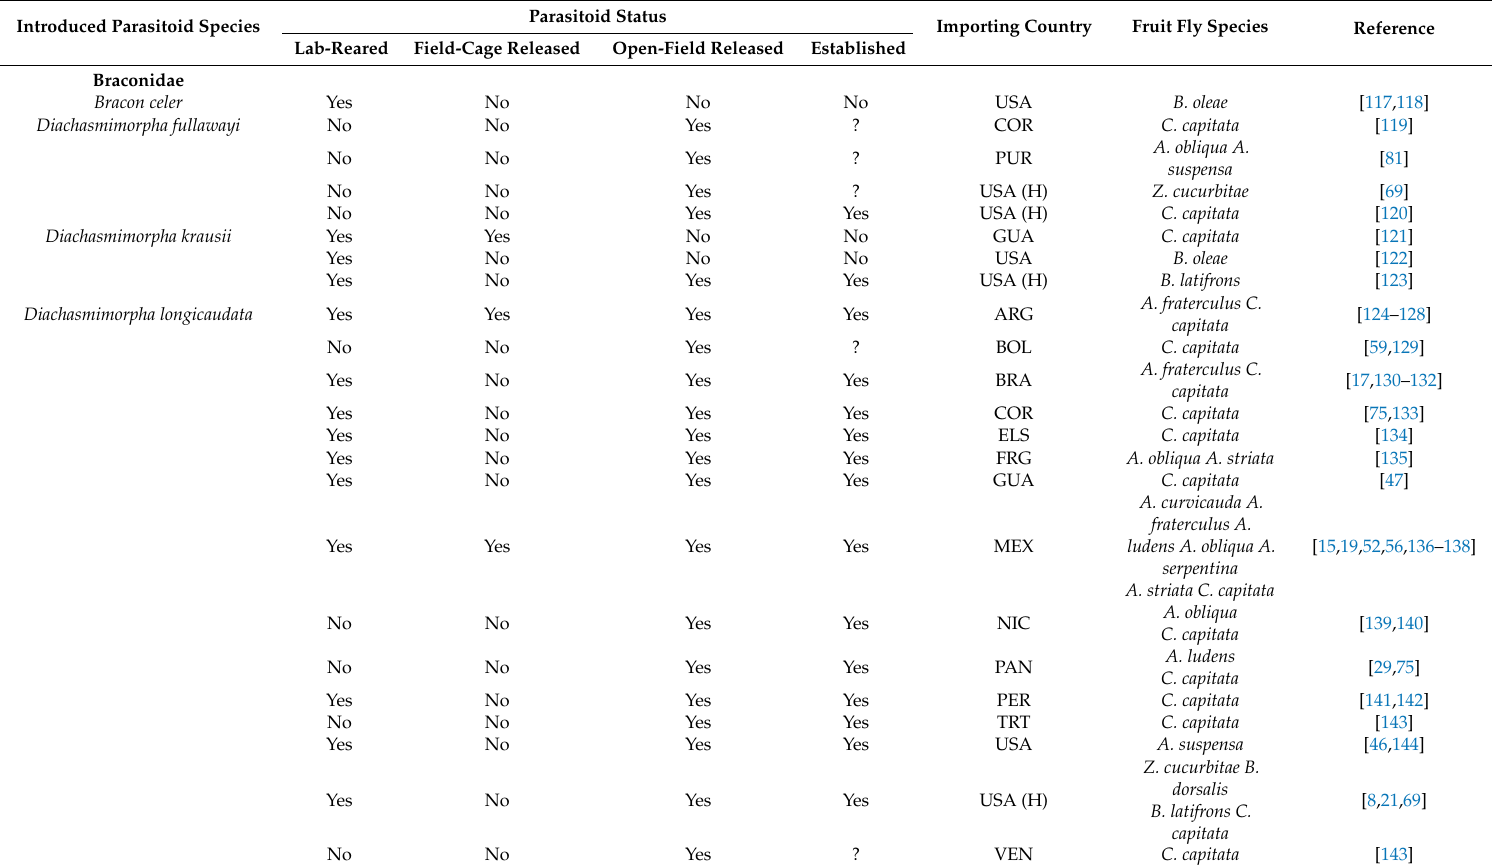
Table 6. Introduced parasitoid species and their target tephritid fruit fly species in the Americas and Hawaii. Introduced Parasitoid